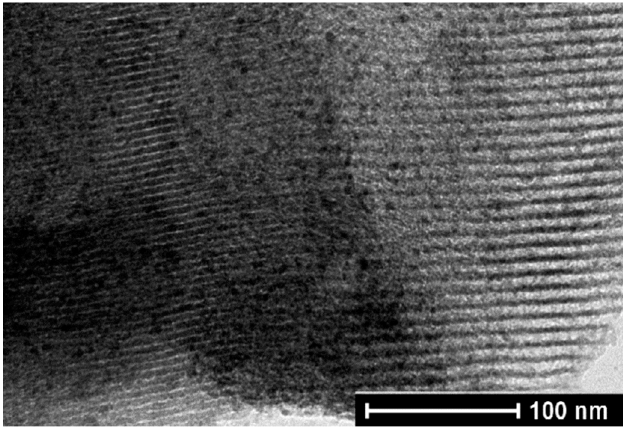
Figure 1. Transmission electron microscopy image of spent FeNP@SBA-15 (after 10 runs).